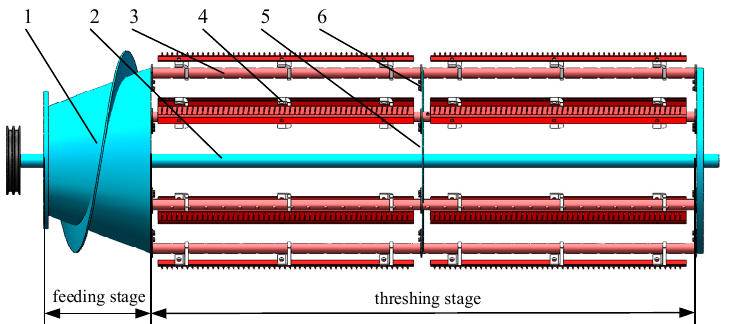
Figure 2. Three-dimensional model of threshing drum: 1. spiral feeding head; 2. drum shaft; 3. rod installation shaft; 4. rod connection seat; 5. spoke disc; 6. threshing gap adjustment device.